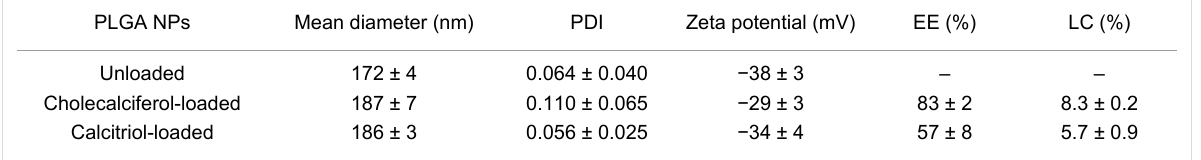
Table 1: Physicochemical features of unloaded, cholecalciferol and calcitriol-loaded PLGA NPs. The data is presented as the mean ± SD ( n = 3).